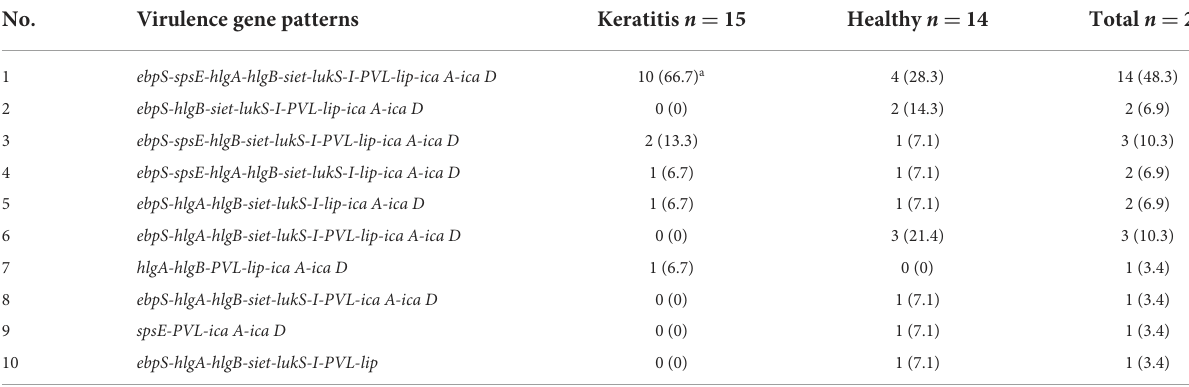
TABLE 7 Virulence gene patterns of 29 isolates of S. pseudintermedius . No.